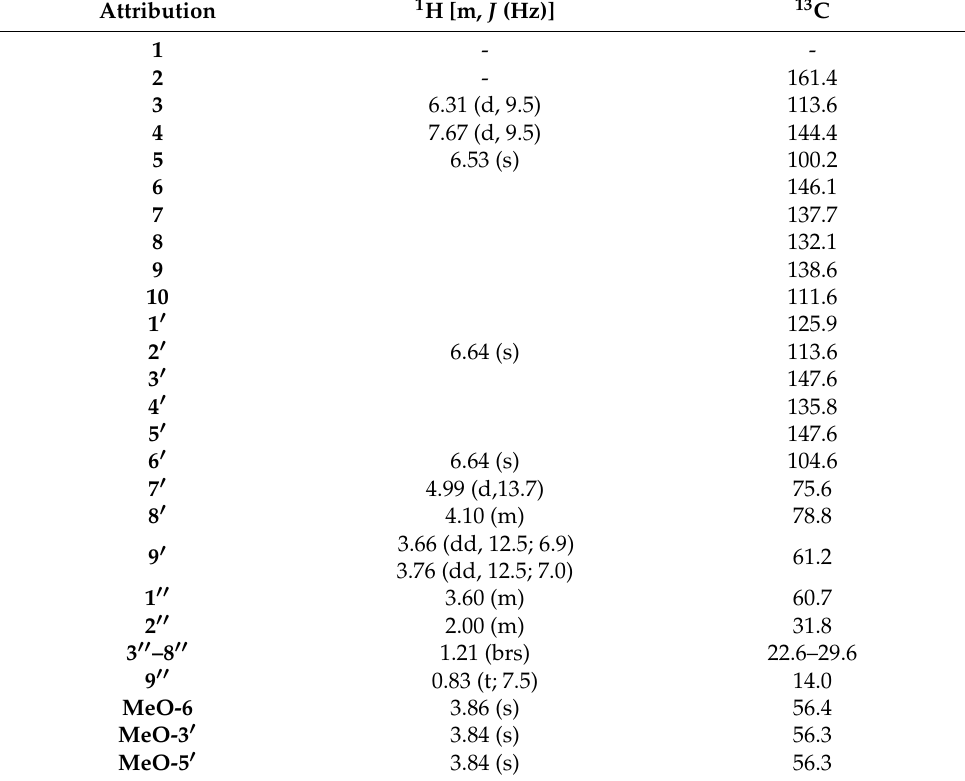
Figure 2. Some correlations of compound 1 HMBC COSY . Figure 3. Some correlations of compound 2 HMBC and COSY . Table 2. 1 H (500 MHz) and 13 C (125 MHz) data of decyloxycleomiscosin D ( 2 ) in CDCl 3 :CD 3 OD (10:1).